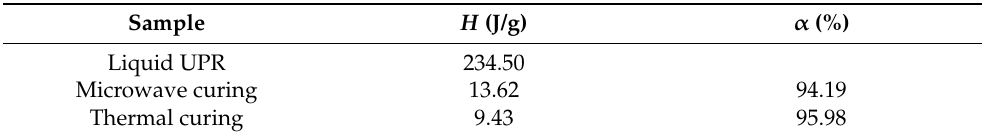
Figure 5. DSC curves of liquid UPR and cured samples with microwave curing and thermal curing, respectively. Table 1. Degree of cure for cured UPR samples.